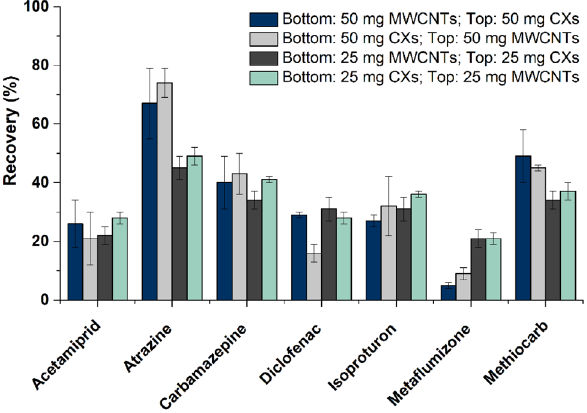
Figure 4. Recovery obtained for the target micropollutants (200 ng L −1 each), when using cartridges with different multi-layer configurations: type of carbon material (pristine CXs or MWCNTs) in each layer (bottom or top) and load of sorbents (25 and/or 50 mg). Experiments performed with 1000 mL of sample (SW; pH 7) and using ethanol as solvent (8 mL); n = 3 (RSD is represented as error bars).